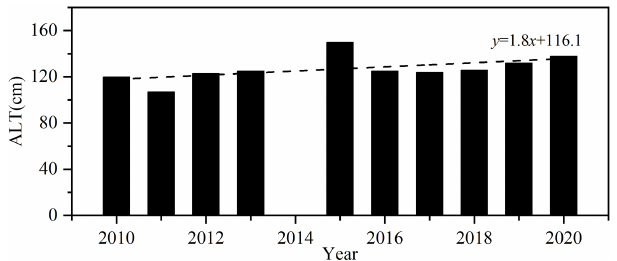
Figure 7. The active layer thickness (ALT) from 2010 to 2020 at the Mahan Mountain permafrost site. The ALT data in 2014 were not